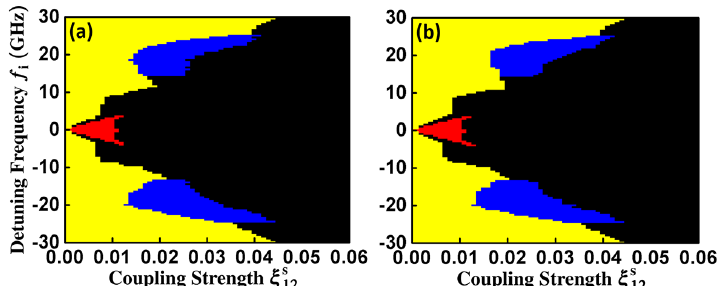
Figure 1. Maps of dynamical states for ( a ) LD1 and ( b ) LD2, respectively, in the mutually-coupled laser system when ξ s = ξ s . Regions of mutual injection locking, P1 dynamics, P2 dynamics, 12 21 and chaos are marked by red, yellow, blue, and black, respectively.